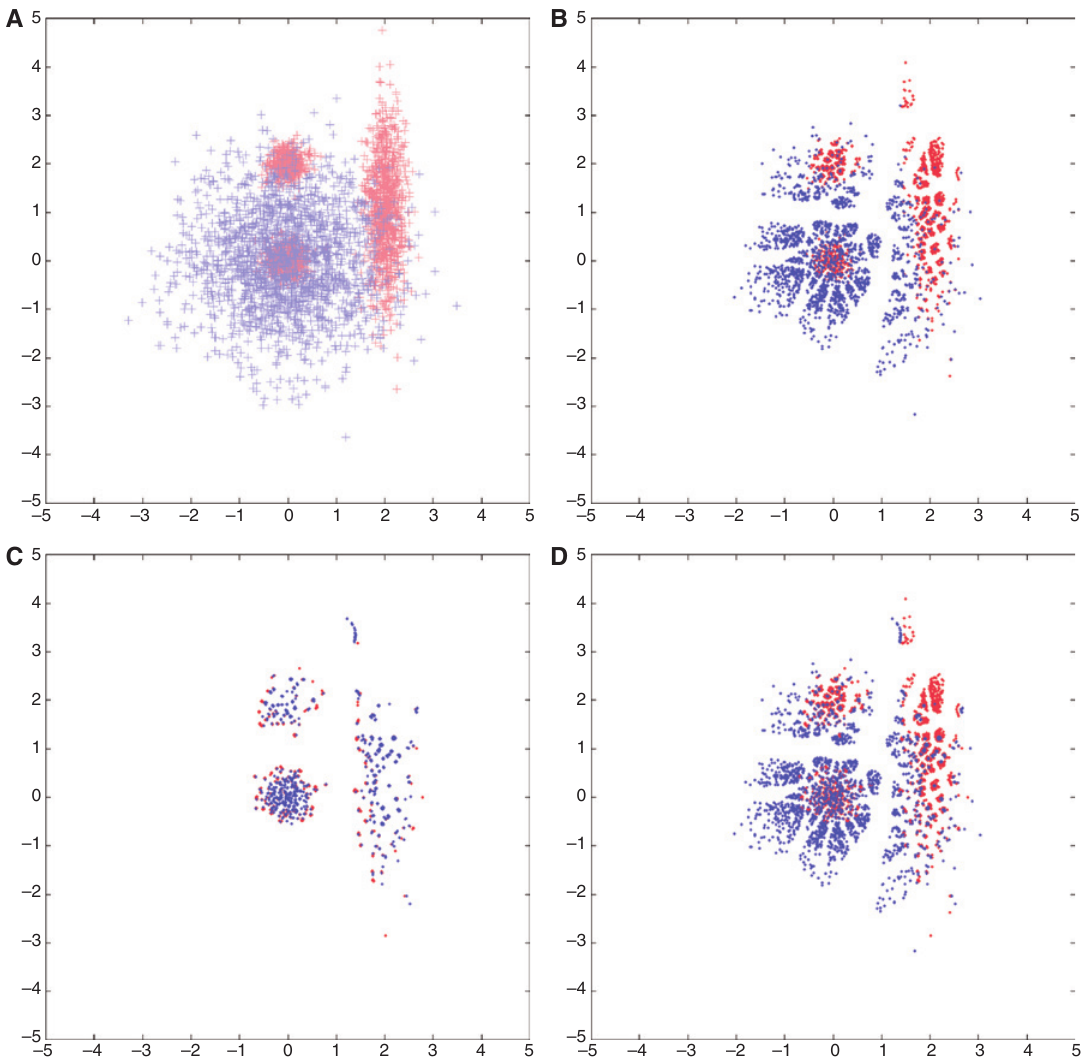
Figure 5: (A) “Clouds” Highly Overlapping Two-Class Synthetic Data Set having 3750 Samples. (B) FMCOVs. (C) AMCOVs. (D) Both FMCOVs and AMCOVs.